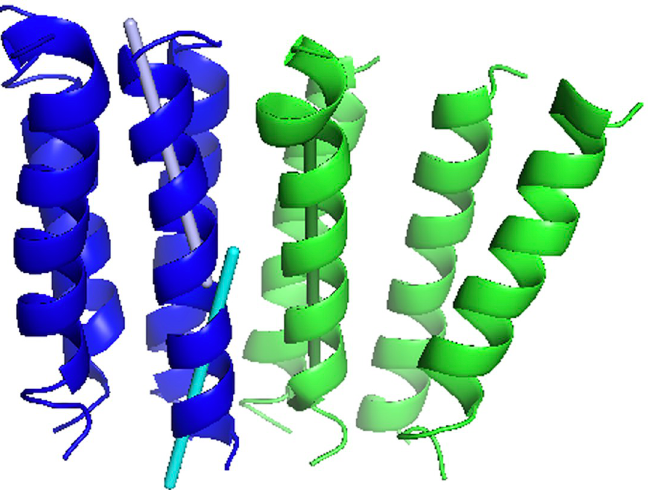
Fig 4. Example of a kinked helix. The transmembrane segments of chain A are in blue, and of chain B are in green (PDB structure 2xq4). Chain A contains a kinked helix with two direction vectors (gray and cyan) used separately in calculation of the interaction angles for that